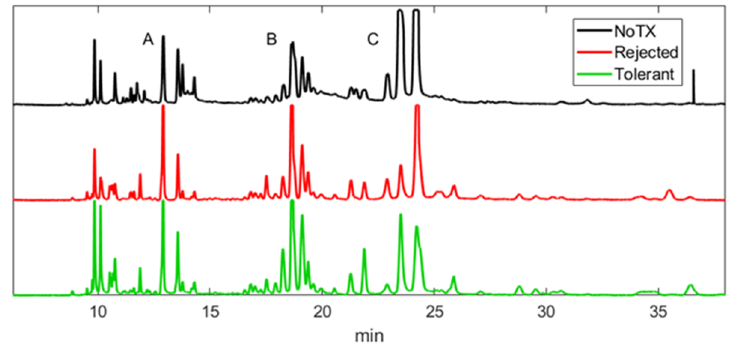
Figure 1. Representative electropherograms (EPGs; shown as voltage versus time in minutes) generated in aqueous humor (AQH) samples obtained from non-transplanted control mice (NoTX; black) and transplant recipients that either rejected (red) or tolerated (green) their intraocular islet allografts. The EPGs showed distinct peak patterns across the experimental groups. Three groups of peaks (corresponding to amino acids and small primary amines) and some ghost peaks were consistently distinguished in each EPG and were designated as group A, B and C. Although the experimental conditions of animals (i.e., NoTX, rejected, tolerant) had a similar general pattern, the number of individual features/metabolites (peaks) and their abundance (peak amplitude/area) within each group were very different among the experimental groups.